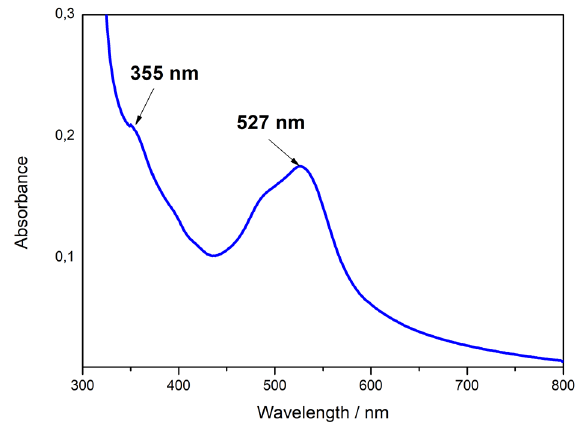
Figure 6. UV–Vis absorption spectrum of a 20/80 MPTMS/TEOS films after immobilizing [Fe(bpy) 3 ] 2+